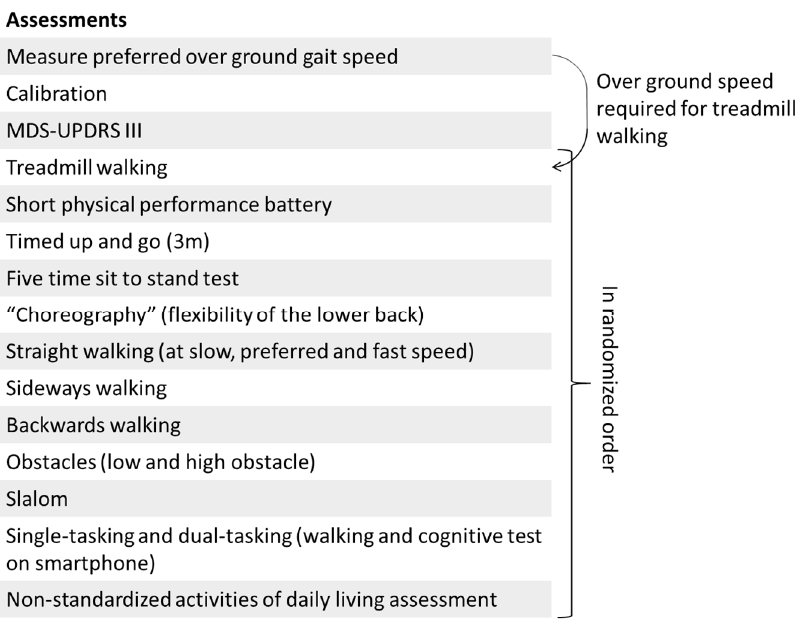
Figure 2. Overview of the protocol. The first three assessments will be performed in this fixed order, the remaining assessments will be performed in randomized order. An explanation of each assessment is provided in the text.